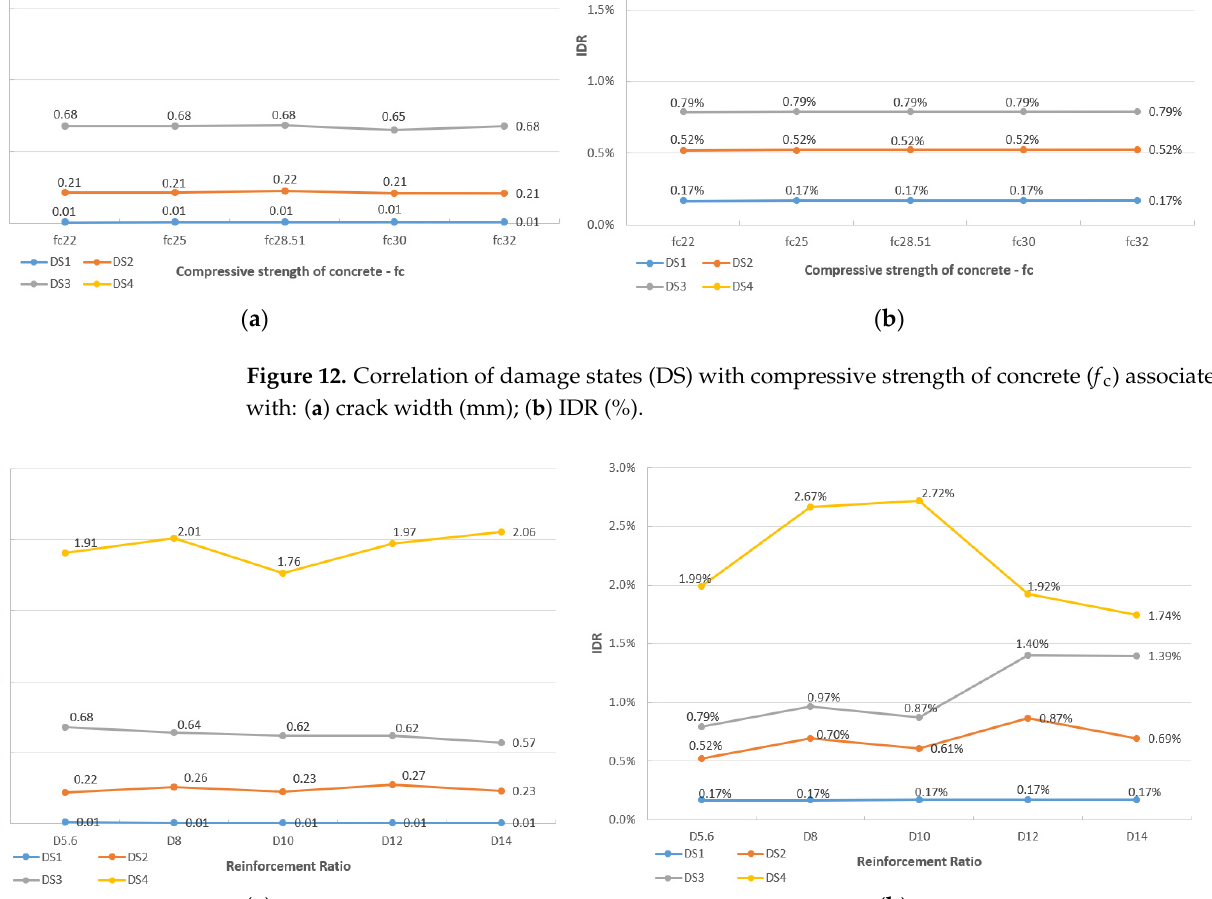
( b ) Figure 14. Correlation of damage states (DS) and yield strength of reinforcement (f y ) associated with: ( a ) crack width (mm); ( b ) IDR (%). ( a ) ( b ) Figure 15. Correlation of damage states (DS) and the compressive strength of masonry (Fm) associ- ated with: ( a ) crack width (mm); ( b ) IDR (%).